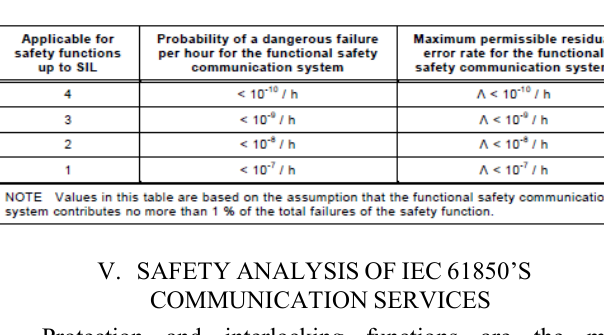
R ELATIONSHIP OF RESIDUAL ERROR RATE TO SIL LEVEL